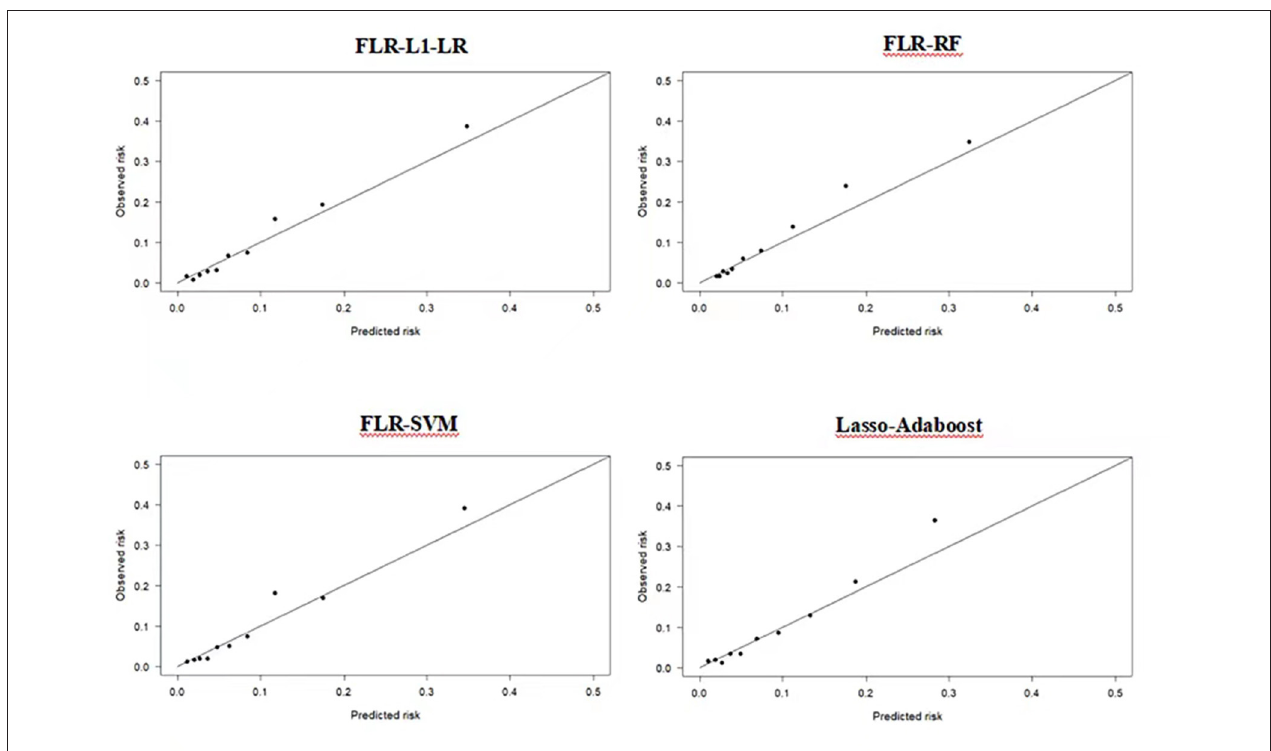
FIGURE 2 | Calibration plots of four ML models in predicting CVD outcomes in Xinjiang rural population. CVD, cardiovascular disease; ML, machine learning; FLR-L1-LR, L1 regularized Logistic regression with forwarding Partial Likelihood Estimation; FLR-RF, Random forest with forwarding Partial Likelihood Estimation; FLR-SVM, Support vector machine with forwarding Partial Likelihood Estimation.